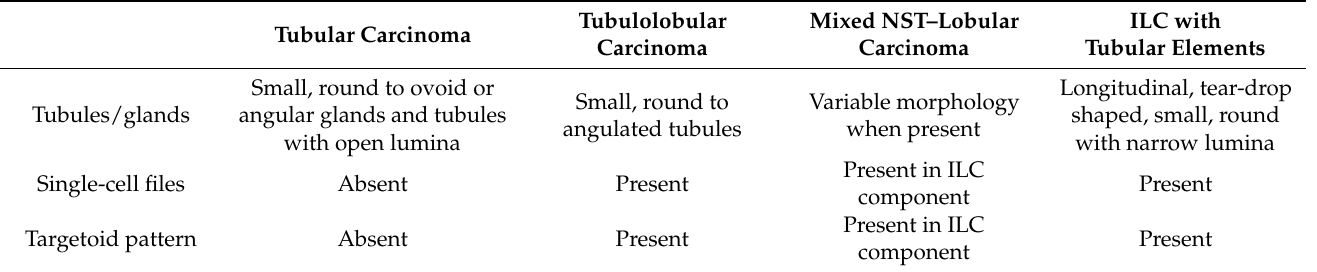
Table 8. Morphological characteristics of invasive lobular carcinoma with tubular elements and its differential diagnoses.